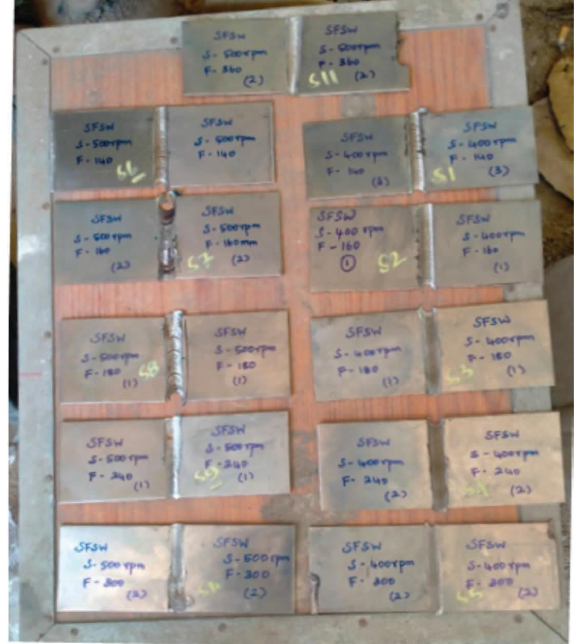
Figure 3: Submerged friction stir welded joints at diferent process